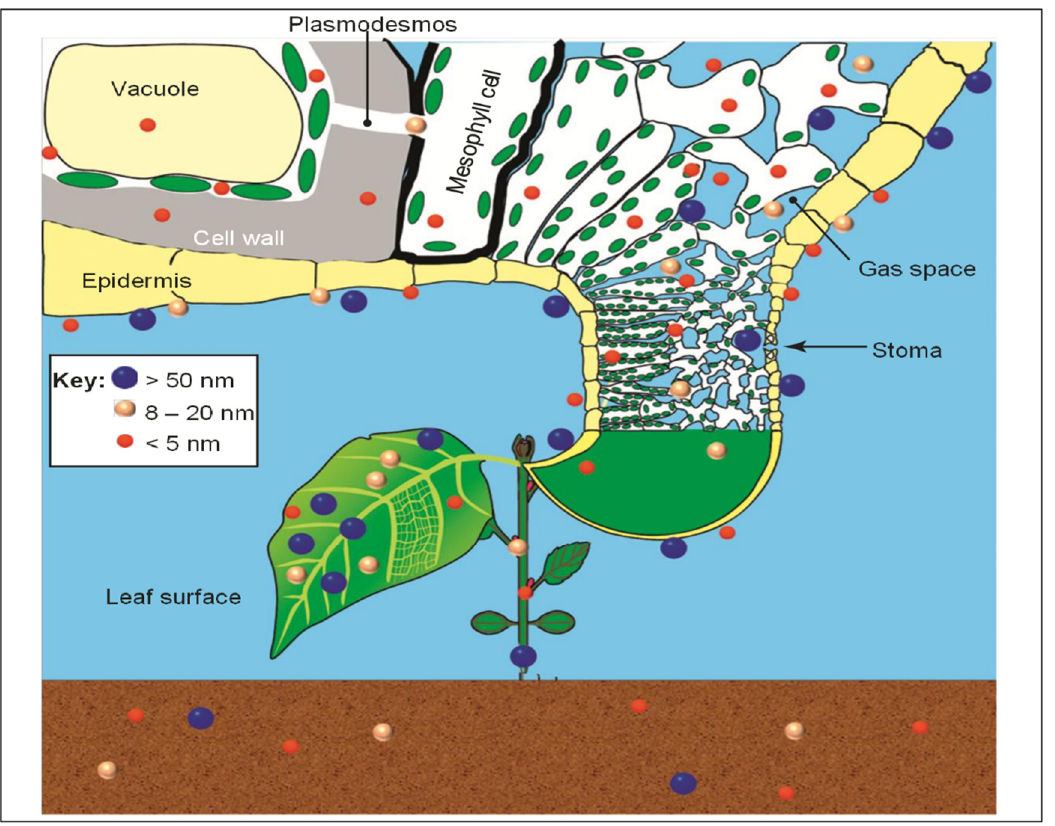
Figure 8. Entry of different sizes of nanoparticles to plant vascular system and mobilization between tissues (adapted from Dietz et al., 2011; copyright 2011 Elsevier)